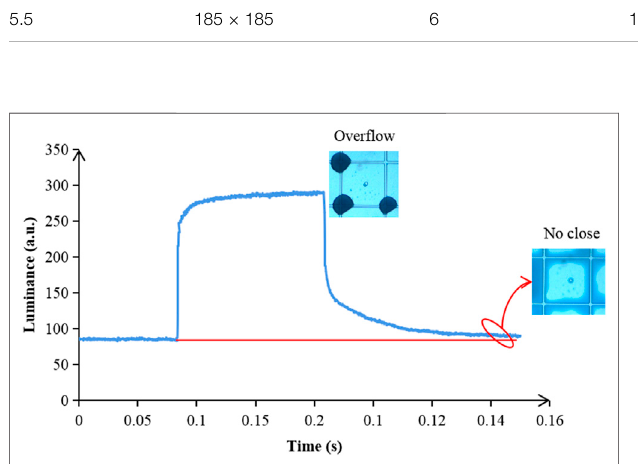
FIGURE 6 | The brightness curve of an EWD driven by a DC voltage for 15 ms. The applied driving voltage was 100 V. The oil fi lm over fl owed to the pixel wall, and it could not cover the whole pixel even power off.